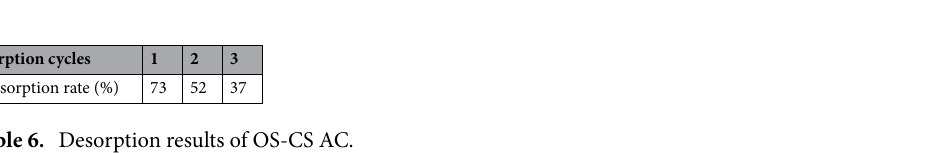
Table 6. Desorption results of OS-CS